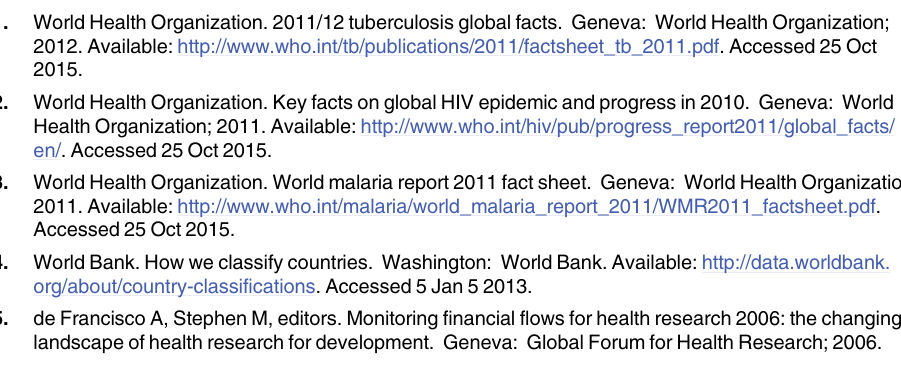
Table K, Group A and Group B Countries Affected by HIV. Table L, Percentage of People Tak- ing First and Second Line Regimens in Group A Countries. Table M, Antiretroviral Treatment Regimen Proportions and Efficacies for Group A and Group B Countries. Some of the material in this section is reprinted from “ Globalization, Global Justice, and Global Health Impact ” under a CC BY license, with permission from Public Affairs Quarterly, original copyright 2014 Section IV. Sensitivity Analyses. (p. 18) Fig B, Initial and Secondary Stability for Sensitivity Analyses. Table N, Drug Accreditation between